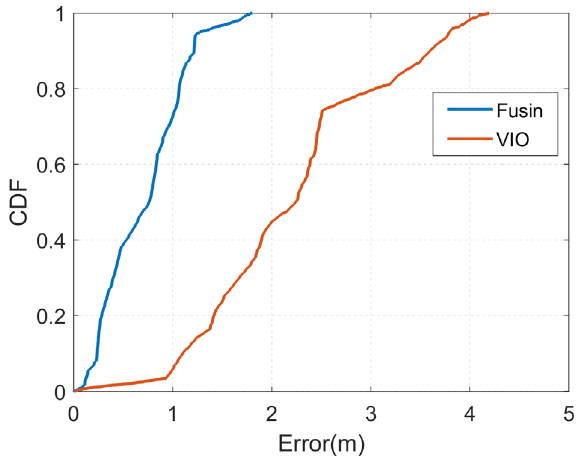
Figure 16. CDF of positioning errors with different method of the covered corridor. Table 4. Position error comparison of the covered